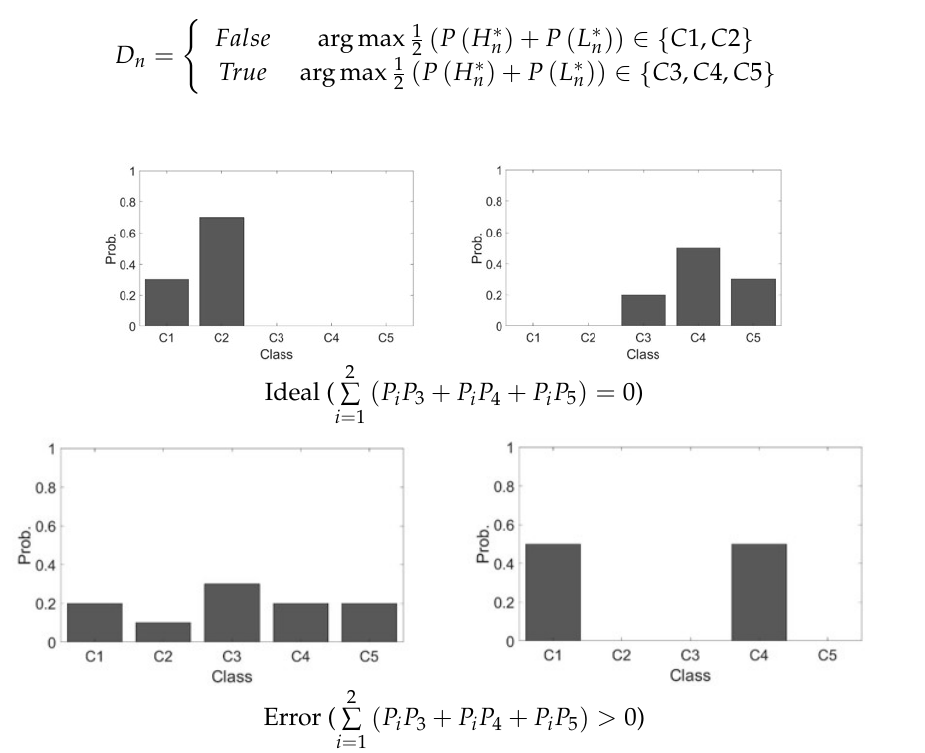
Figure 8. An example of orthogonal